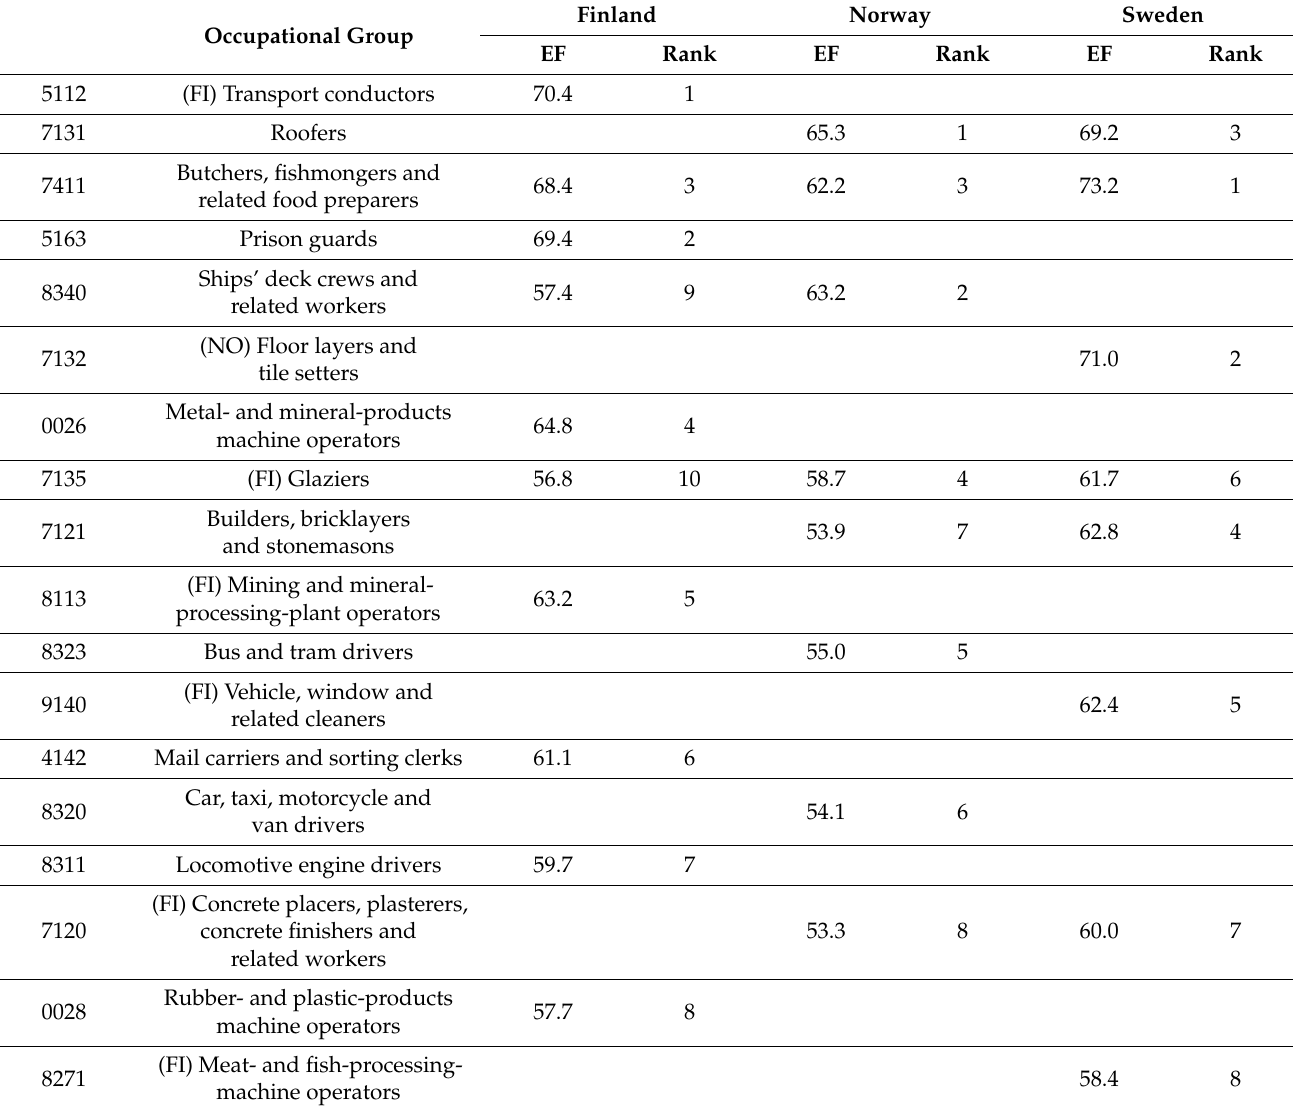
Three occupational groups—“telephone switchboard operators”, “professionals and asso- ciate professionals in social work” and “nursing and care assistants”—were among the top 10 ranked groups based on SA due to mental disorders (Table 4). Table 3. Occupational groups with rank 1–10 based on the excess fraction (EF, %) of the age-adjusted one-year cumulative incidence of prolonged sickness absence due to musculoskeletal diseases among men in Finland, Norway and